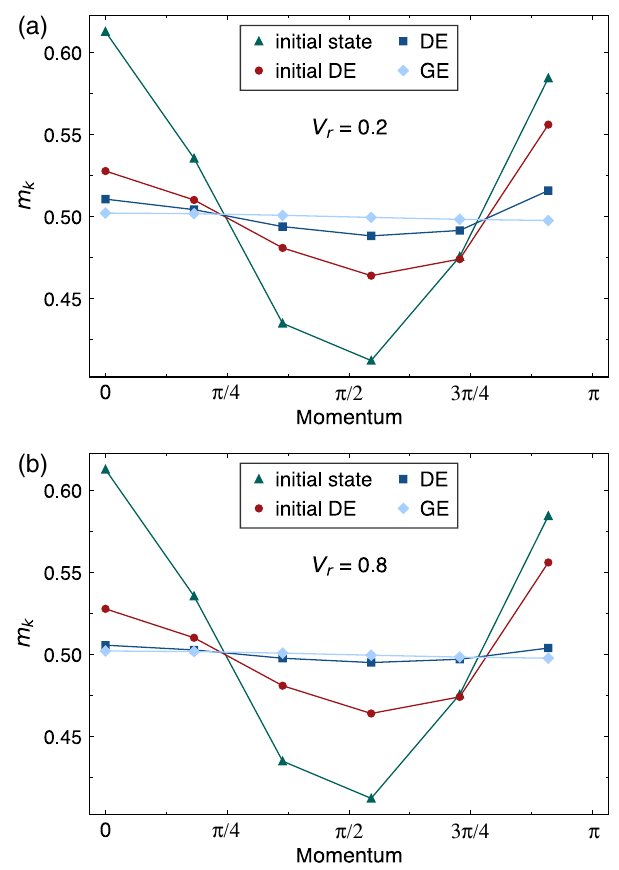
FIG. 16. Examples of momentum distributions ( m the exact diagonalization calculations of the two-rung hard-core boson model with L ¼ 22 . We show the momentum distributions for an initial state (labeled as “ initial state ” ), the diagonal ensemble after the quench to the integrable part of as “ initial DE ” ), the diagonal ensemble after the quench to (labeled as “ DE ” ), and the grand canonical ensemble prediction for the thermal momentum distribution after the quench (labeled as “ GE ” ). For the quenches, we set V ¼ 1 . 6 , with (a) V 0 . 8 . The momentum distribution of the initial state and (b) V r ¼ and of the diagonal ensemble after the quench to the integrable ˆ H part of are the same in (a) and (b); only the diagonal and grand F canonical ensemble predictions change due to the change of V